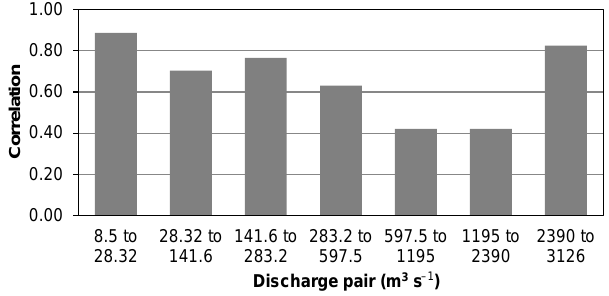
Figure 8. Pearson’s correlation coefficient for sequential pairs of flow-dependent wetted width series.